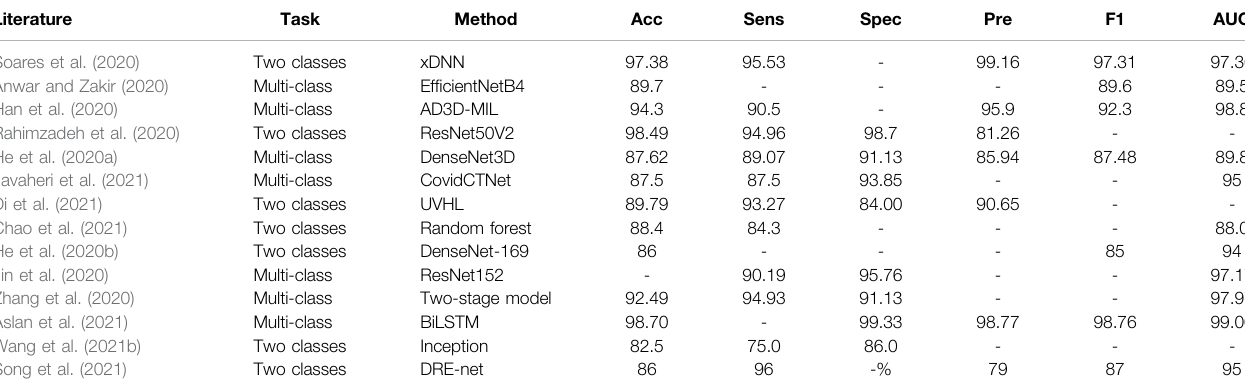
TABLE 2 | Summary of COVID-19 detection from lung CT slides in the literature (%). If multiple models are used in a study, we report the best-performance model